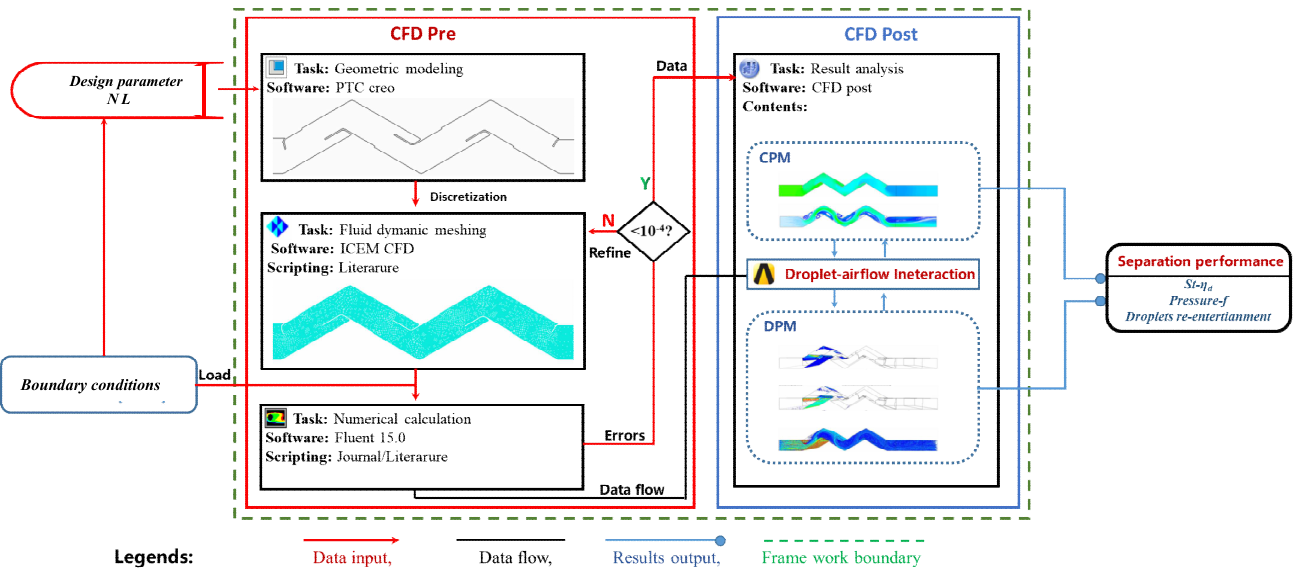
Figure 1. Detailed scheme of CFD investigation.